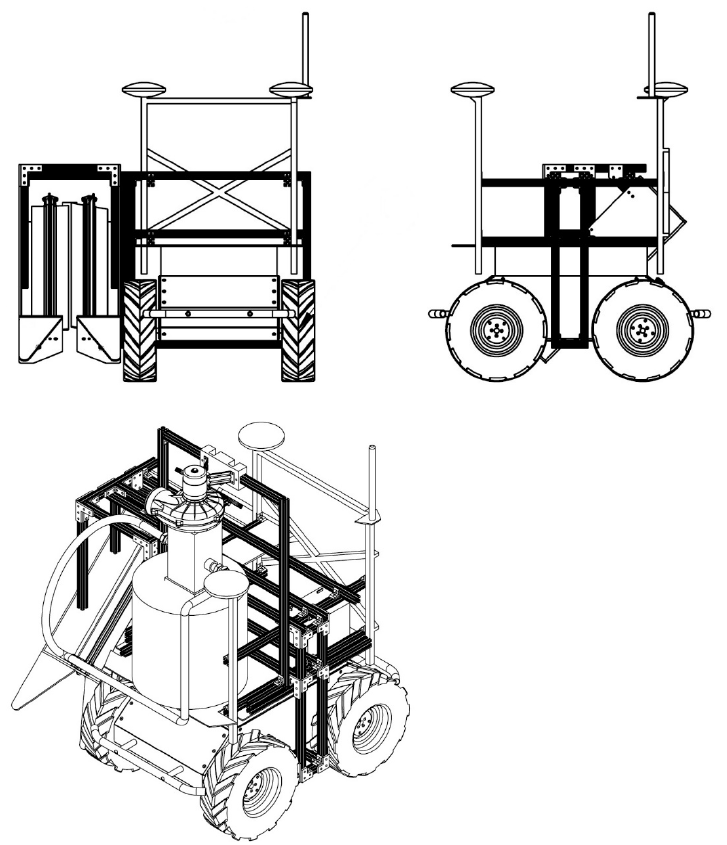
Figure 4. The next generation of cotton harvesting autonomous platform .